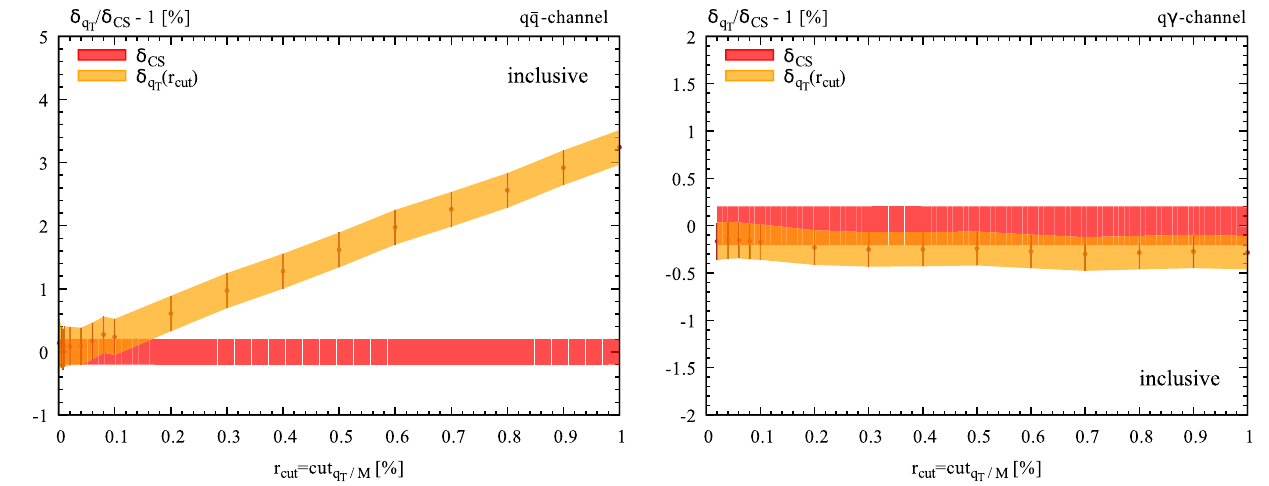
independentcrosssectioncomputedwithdipolesubtraction.Thelepton mass is fixed to m l = 10GeV. No cuts are applied